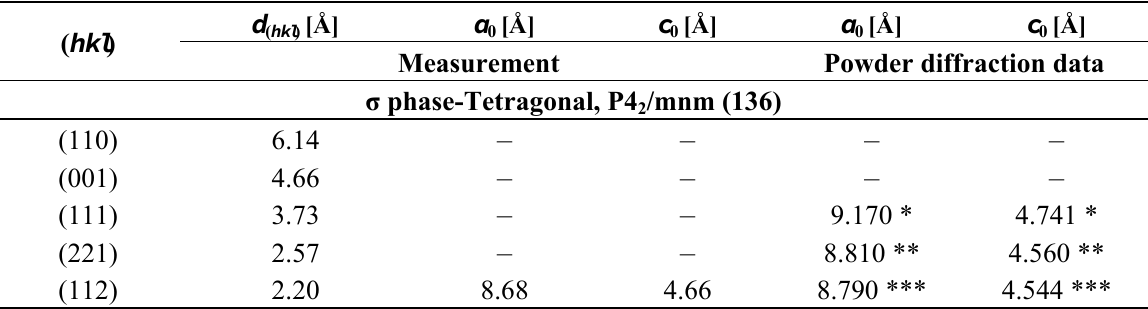
Table 5. The measured values of d as-cast Haynes ® 282 ®